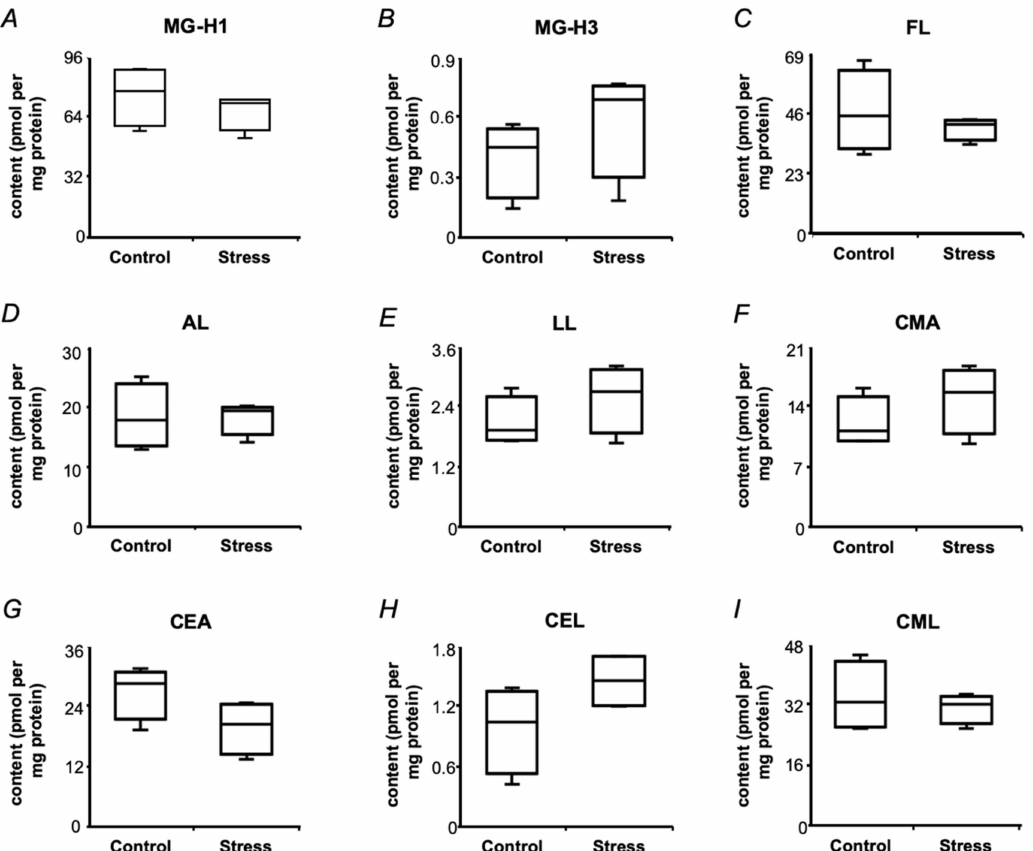
Figure 9. The contents of individual AGEs in mature pea ( Pisum sativum L., cultivar SGE) seeds after a two-day exposure of plants (at the seed maturation step) to the aqueous medium with and without addition of 2.5% ( w / v ) PEG 8000 (defined as Stress and Control, respectively). The analysis relied on ion pair-reversed phase high-performance liquid chromatography coupled on-line to electrospray ionization-triple quadrupole tandem mass spectrometry (IP-RP-HPLC-ESI-QqQ-MS / MS). MG-H1, methylglyoxal-derived hydroimidazolone 1, N δ -(5-hydro-5-methyl-4-imidazolon-2-yl)ornithine methylglyoxal-derived hydroimidazolone 3, N δ -(2-hydro-5-methyl-4-imidazolon-2-yl)ornithine ( B ); FL, N ε -(formyl)lysine